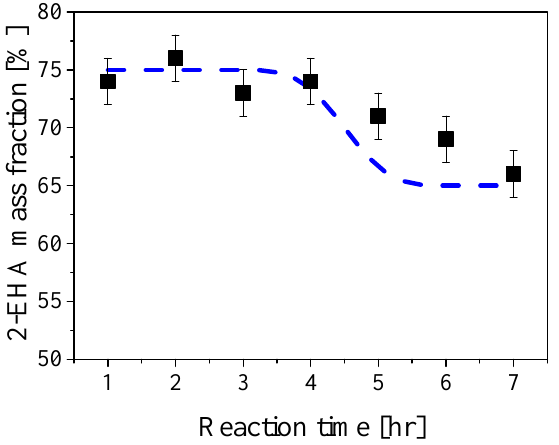
Figure 3. Mass fraction of 2-EHA in the polymer particles for sample a during the reaction. The dashed curve represents the cumulative polymer composition corresponding to the fed monomer mixture assuming complete